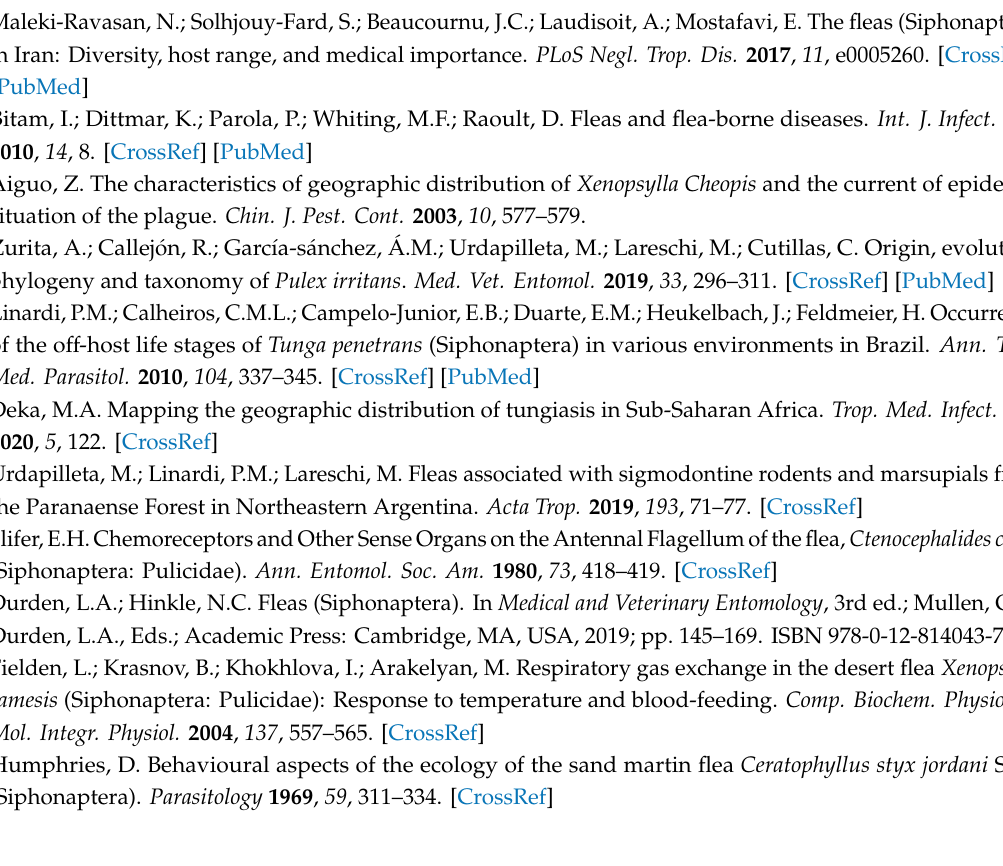
Table S1: Number of collected fleas in particular